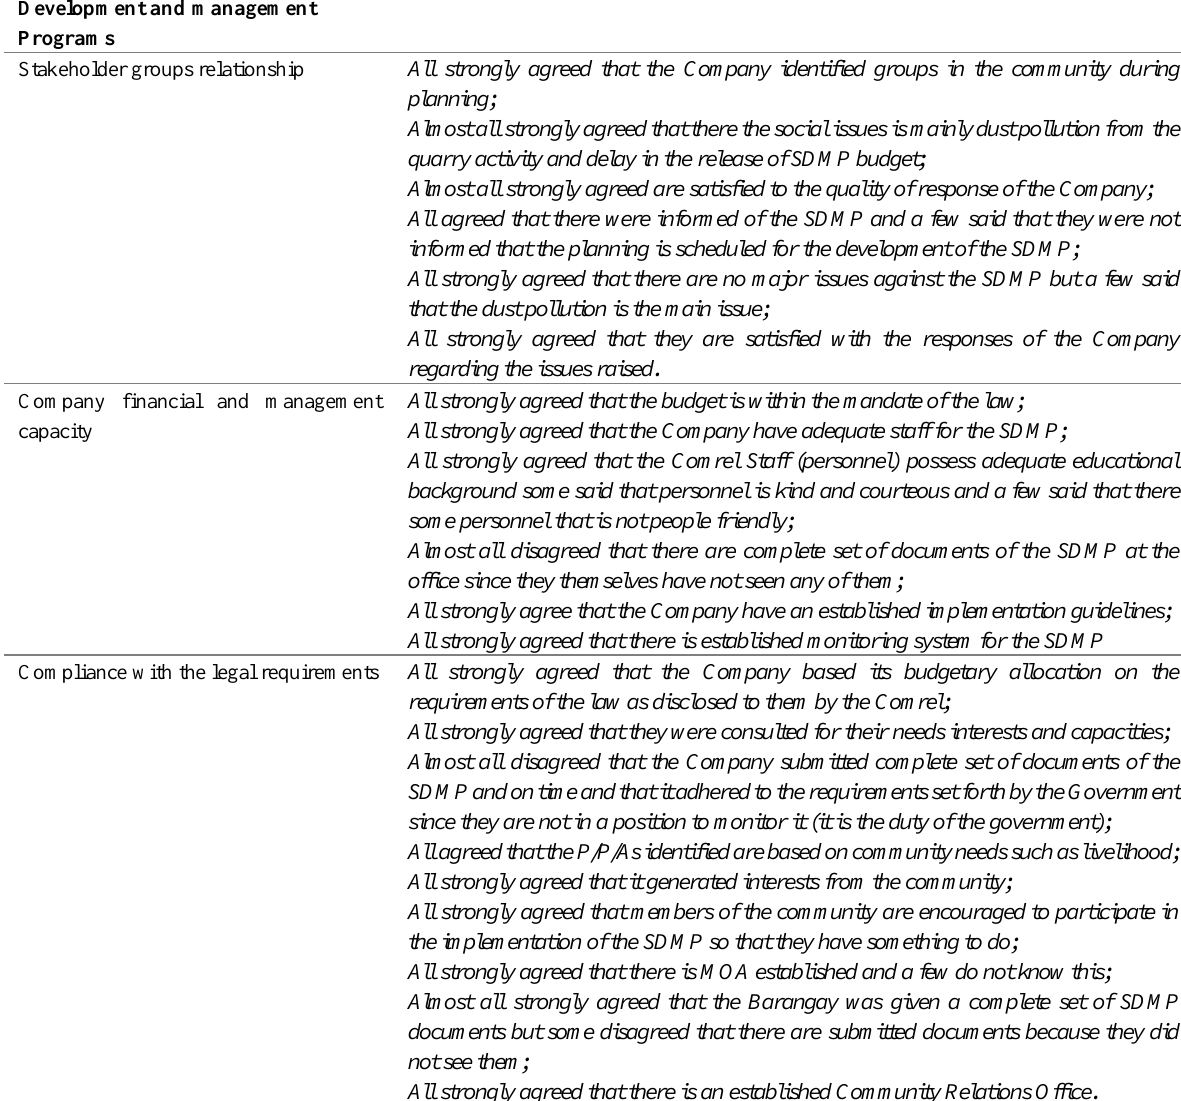
Table 2: Perception of the respondents on the sustainability of the Social Development and Management